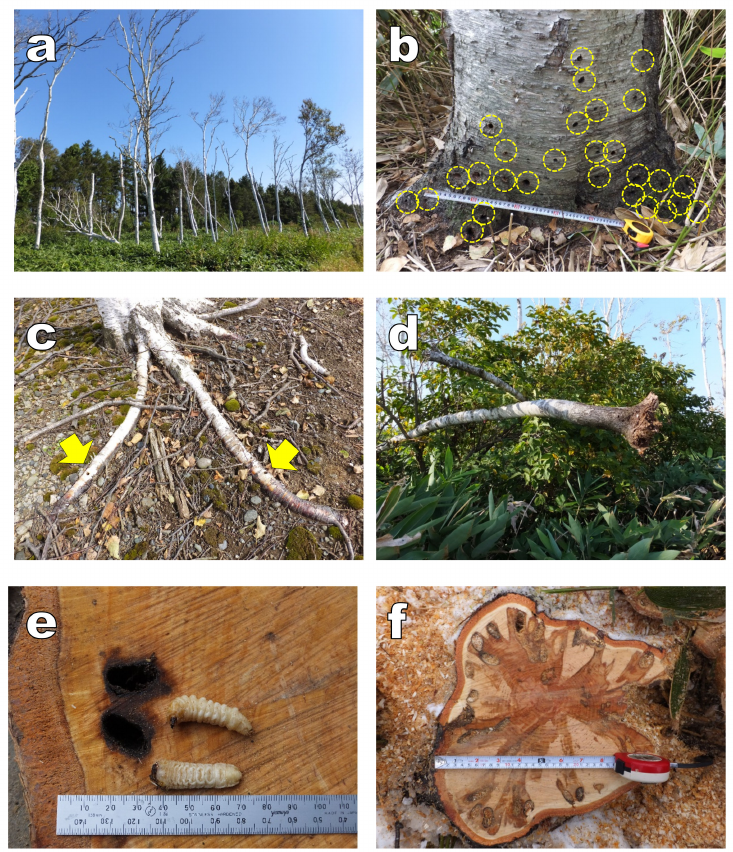
Figure 1. Infestation of white birch shelterbelts by white-spotted longicorn beetle. The follow- ing locations and plot numbers are shown in Figure 2. ( a ) Degraded stand at Plot 7 in Bibai on 21 September 2016. ( b ) Adult exit holes observed at the trunk base (dotted circles) at Plot 15 near the degraded stands, i.e., Plots 12 and 13. ( c ) Adult exit holes on the root, as shown by the arrows on 14 October 2016 (from [22]). ( d ) Snapping of trees at the trunk base at Plot 13 on 26 September 2016 (from [22]). ( e ) Larvae of white-spotted longicorn beetle in sapwood on 5 December 2016. ( f ) Cross-section of wood at ground level. Palmate discolored area elongates toward the tunnel bored by the larvae on 1 December